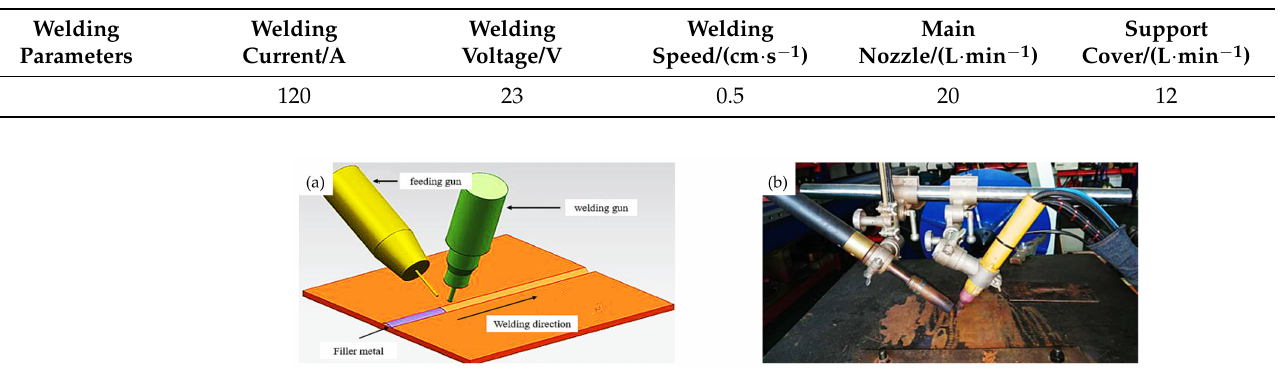
Figure 1. The welding schematic diagram and physical photograph. ( a ) Schematic diagram; ( b ) Phys- ical photograph.